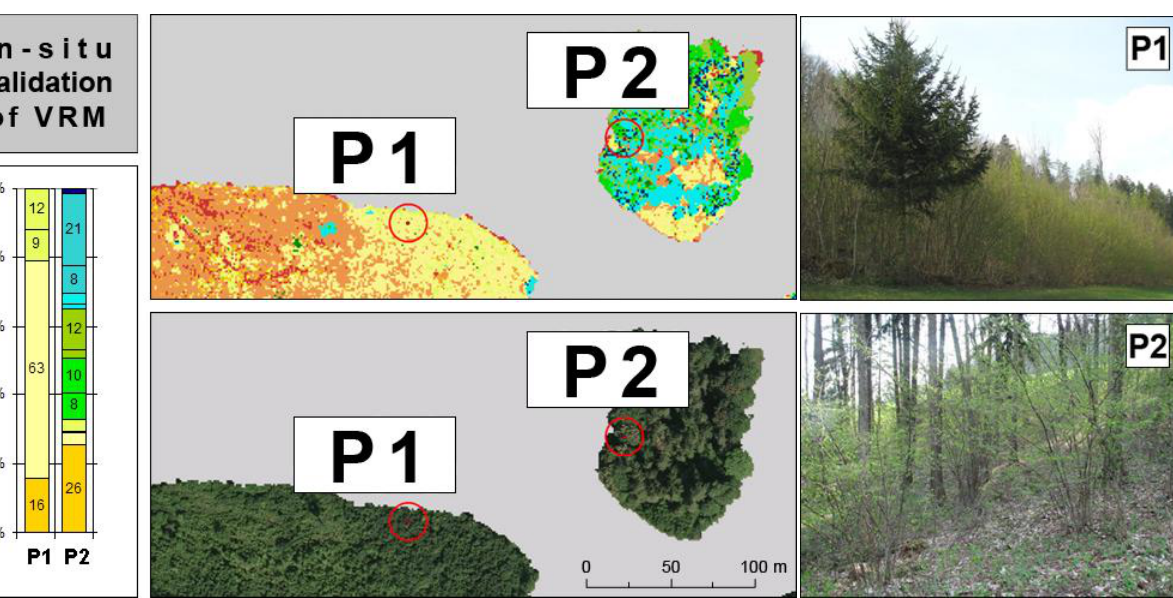
Figure 11. In situ validation of VRM for a detail of the test site Bucklige Welt